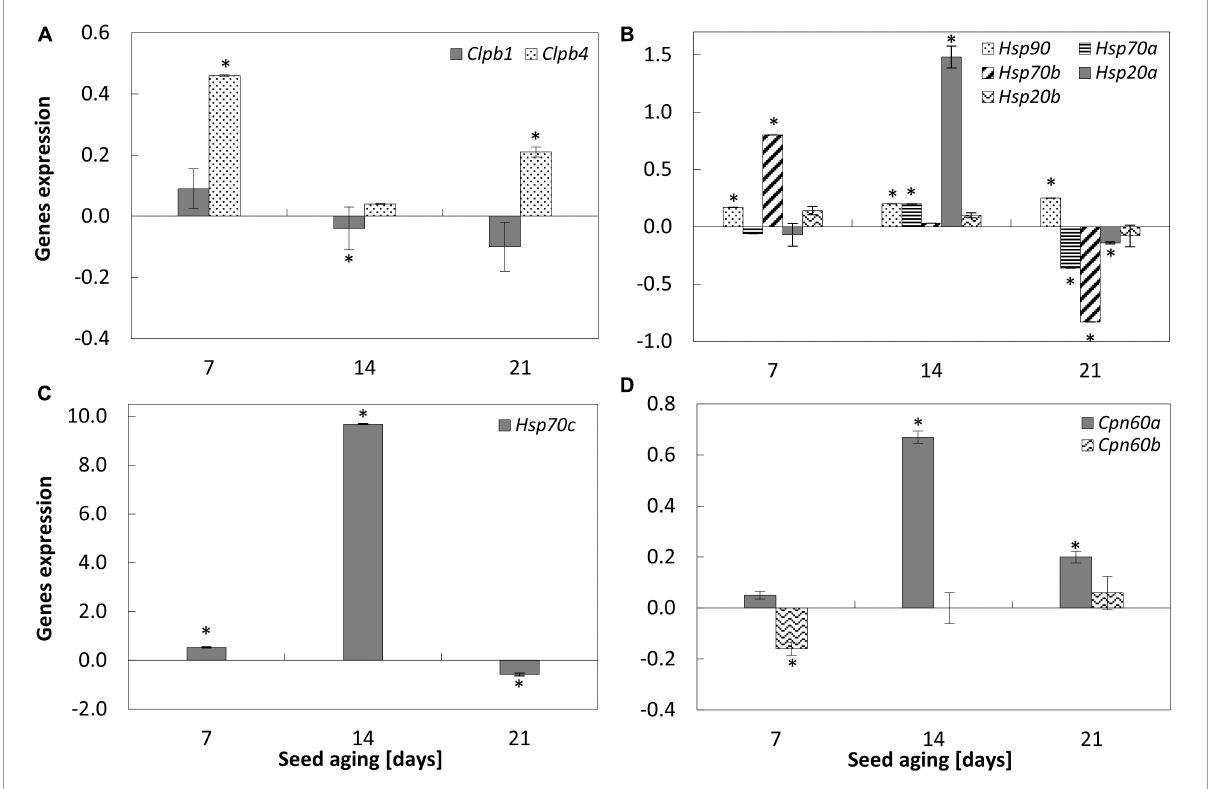
FIGURE3 NO-induced modifications in the expression of ClpB1 and ClpB4 (A) , Hsp90 , Hsp70a , Hsp70b , Hsp20a , Hsp20b (B) , Hsp70c (C) , Cpn60a and Cpn60b (D) in the embryonic axes of apple seeds subjected to accelerated aging for 7, 14, and 21 days. Values are average ± SD of 3 repetitions. Asterisks indicate significant differences between the treated sample compared to the control sample, obtained by the Student’s t -test ( P <